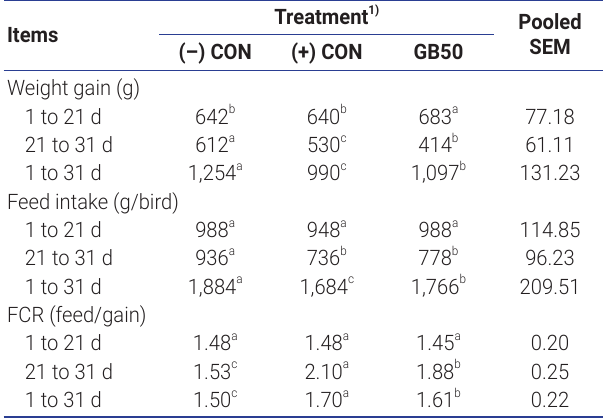
Table 5. Growth performance, feed intake and feed conversion ratio of broiler chickens in overcrowding environment (Trial 3) Items